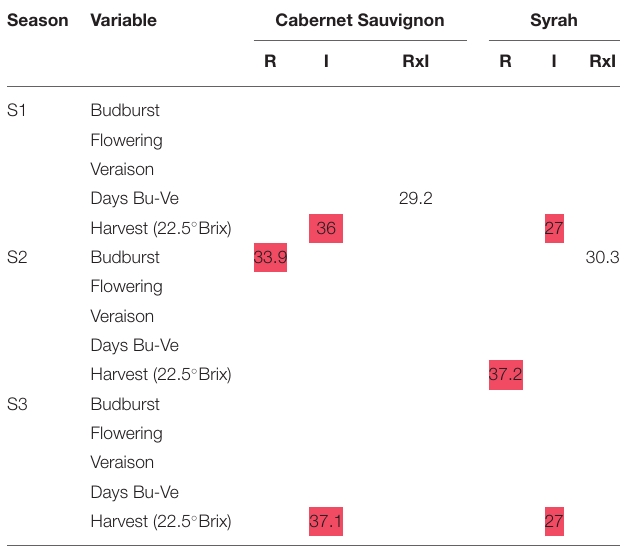
TABLE 3 | Percent of variance explained by each factor (Rootstock and Irrigation) and the interaction (RxI) for the phenological variables in each cultivar and season. Season